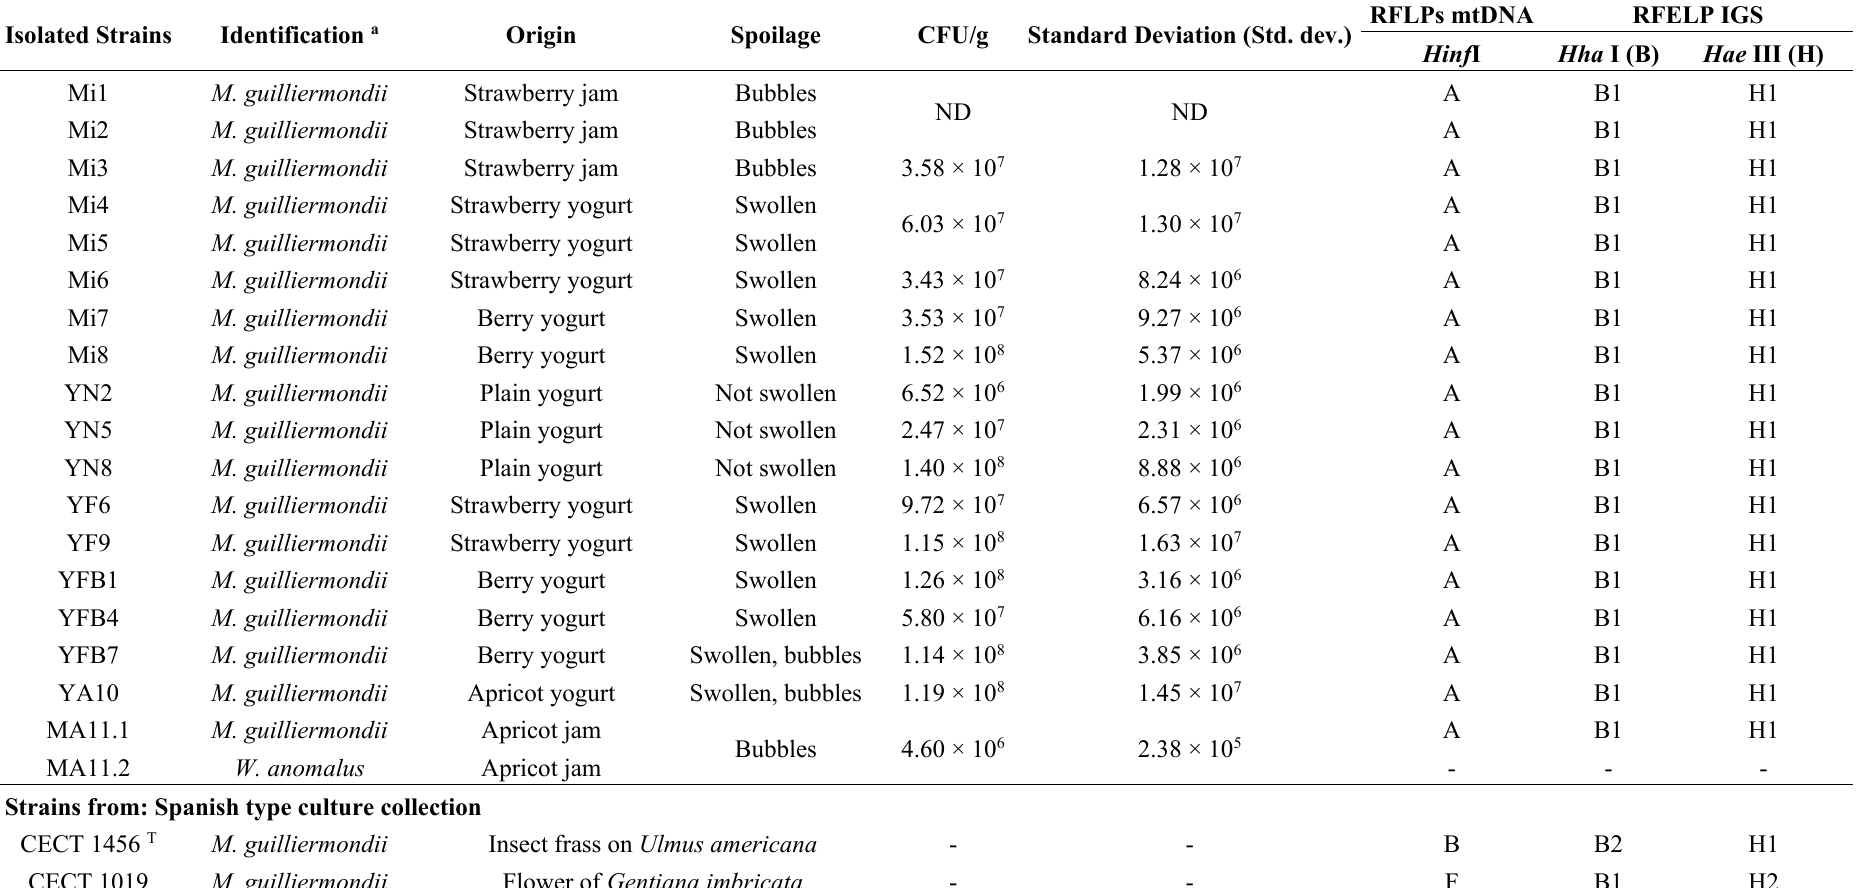
Table 1. Strains isolated from different samples and strain collection, origin, type of spoilage, and patterns obtained by RFLP mtDNA (Restriction Analysis of the mitochondrial DNA) and by PCR IGS-RFLP. Isolated